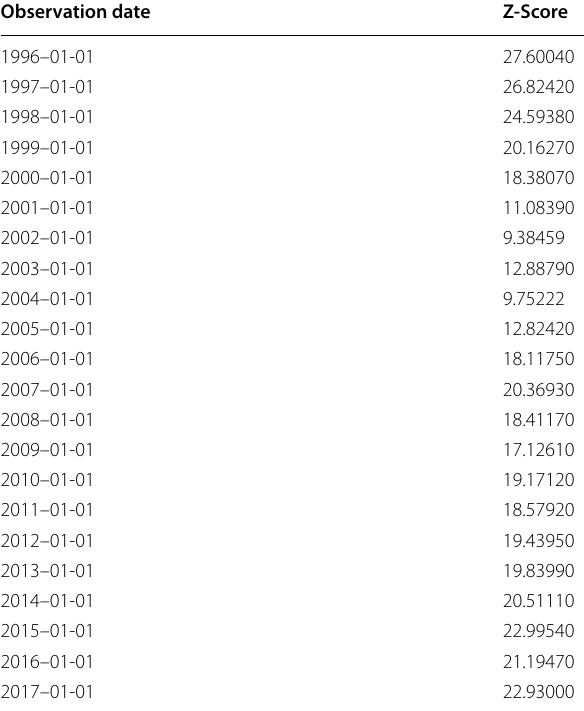
Table 4 China bank Z-score per